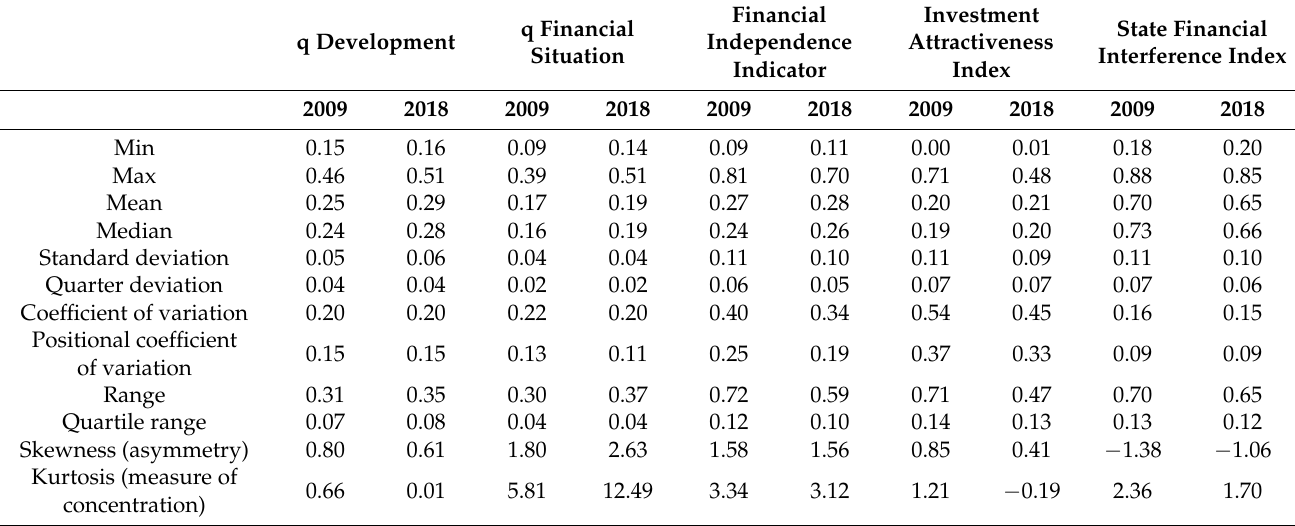
Table 4. Statistical characteristics of the synthetic measure of the financial situation of rural communes in eastern Poland in 2009 and 2018.